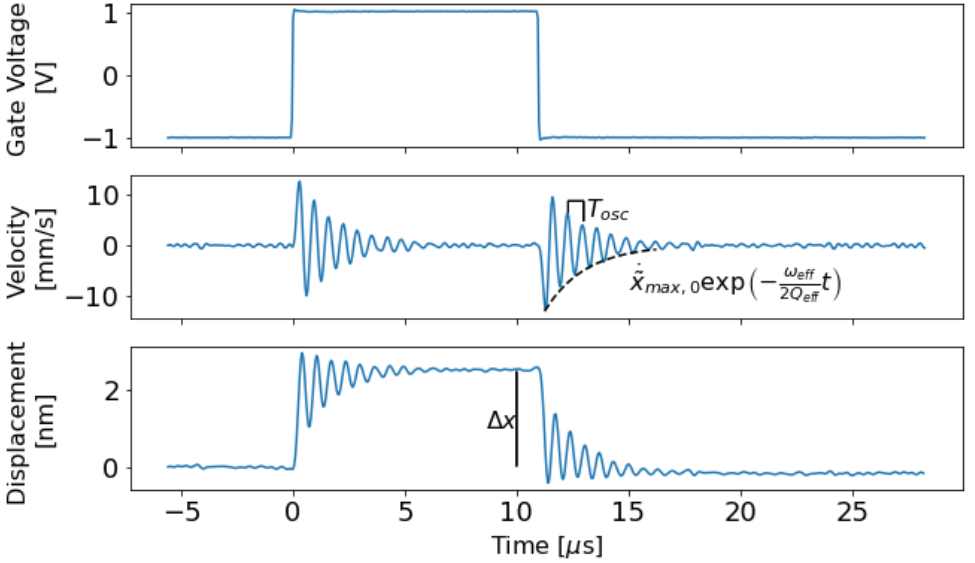
Figure 2. Data collected from a LDV trial. Because the body is at a high, positive bias Voltage, the rising edge of the gate Voltage curve causes the relay to open while the falling edge causes the relay to close. Velocity measured by LDV and displacement calculated by integrating the measured velocity are displayed. The velocity noise deviation is 790 µ m/s according to the LDV data sheet: it is given √ √ by a noise density of 0.5 µ m/s/ Hz times the square root of the bandwidth, 2.5 MHz [19]. This is higher than the deviation observed in the measured velocity curve above, and may represent a worst case measurement. The LDV displacement resolution, estimated by integrating the velocity noise deviation over the sampling window of 50 ns, is 40